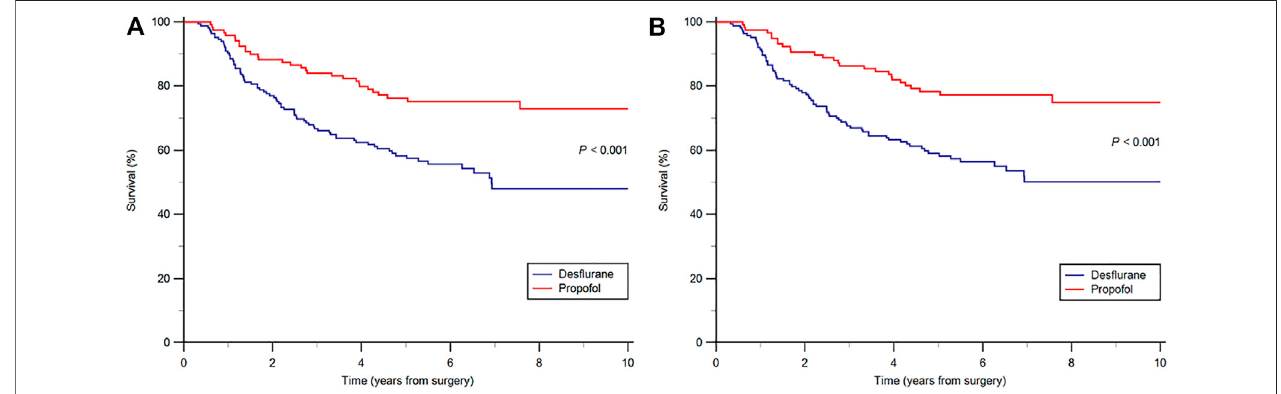
Frontiers in Pharmacology |